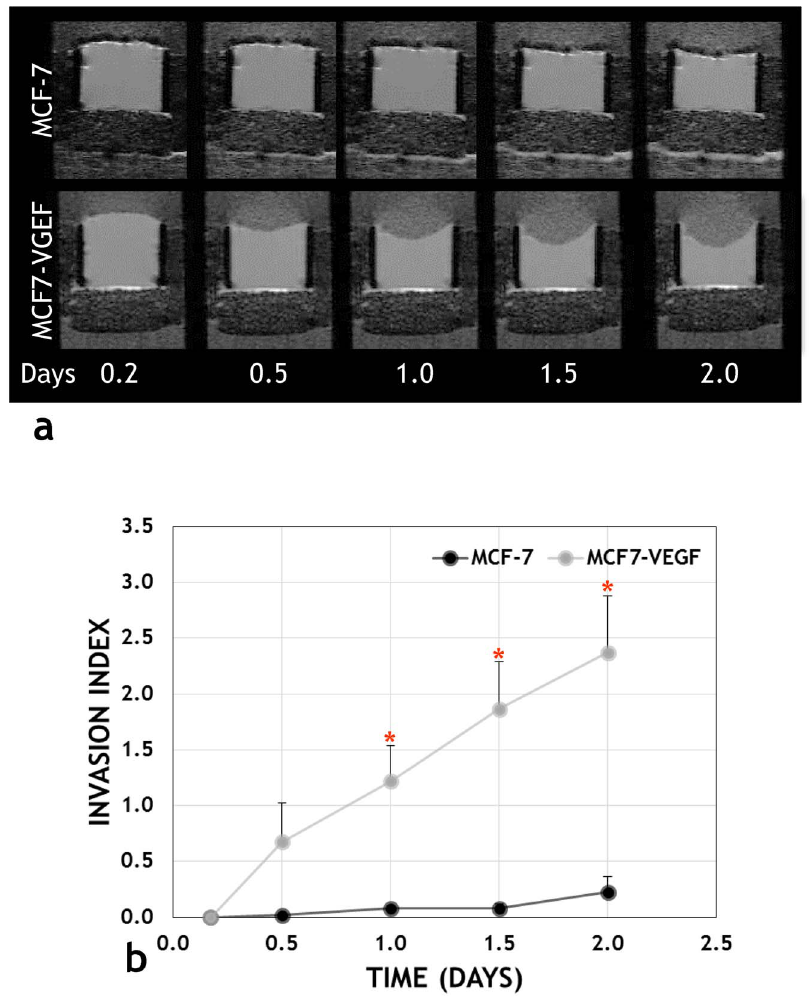
Figure 2. VEGF overexpression increases the invasiveness of MCF-7 cells. (a) Representative MR images of Matrigel H acquired from a MR compatible perfusion chamber over 48 h, which demonstrate significant Matrigel H degradation by MCF-7-VEGF (lower panel) cells in contrast to MCF-7 cells. (b) The time-dependent invasion indices showed a significant (*p=0.024, p=0.026 and p=0.025, respectively with the two-tailed Aspin- Welch Unequal-Variance Test) increase in invasion by MCF-7-VEGF cells compared to MCF-7cells, at 1, 1.5 and 2